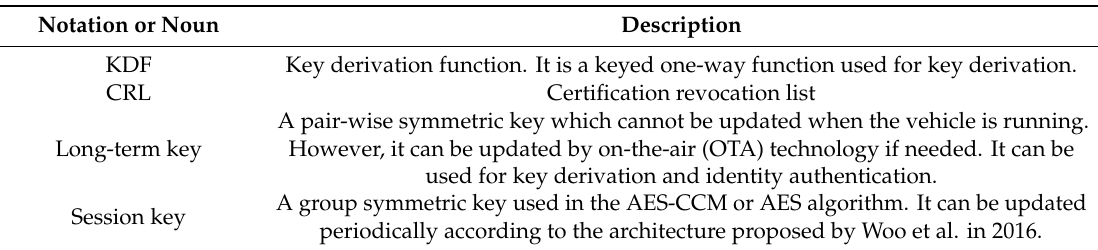
Table 2. Notations used in key update for multi-layer electronic control units